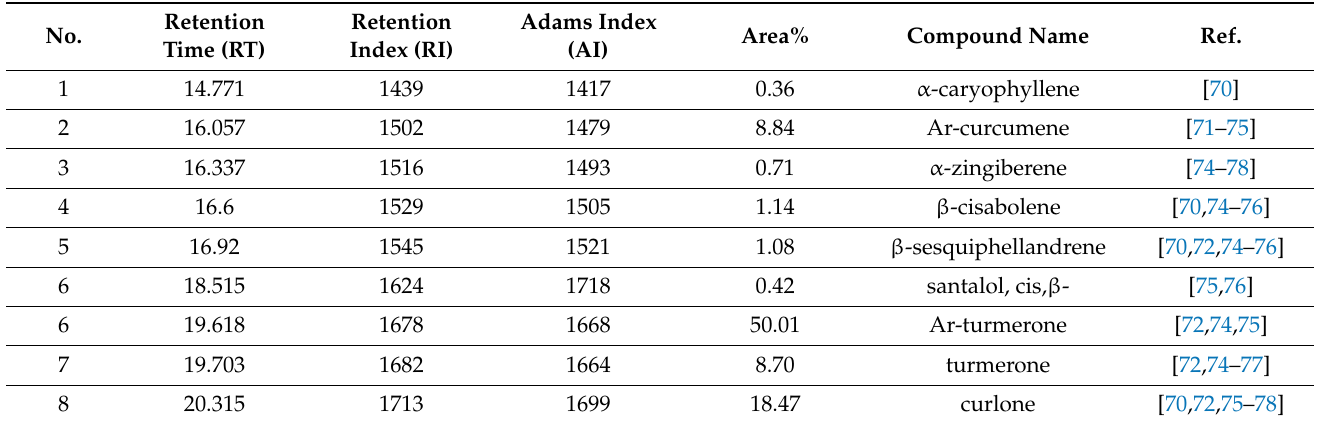
Table 1. Main compounds identified by GC-MS analysis of a curcuma sample.